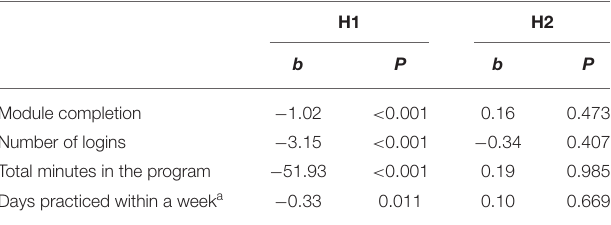
TABLE 4 | Outcome variables predicted by being in the randomization group or not (hypothesis H1) and receiving SMS or not in the randomized group (hypothesis